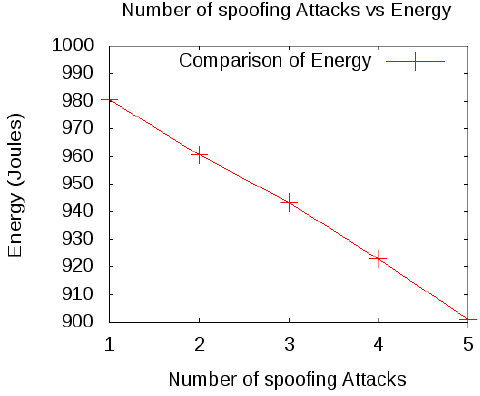
Figure 8. Energy in the absence of spoofing attack.